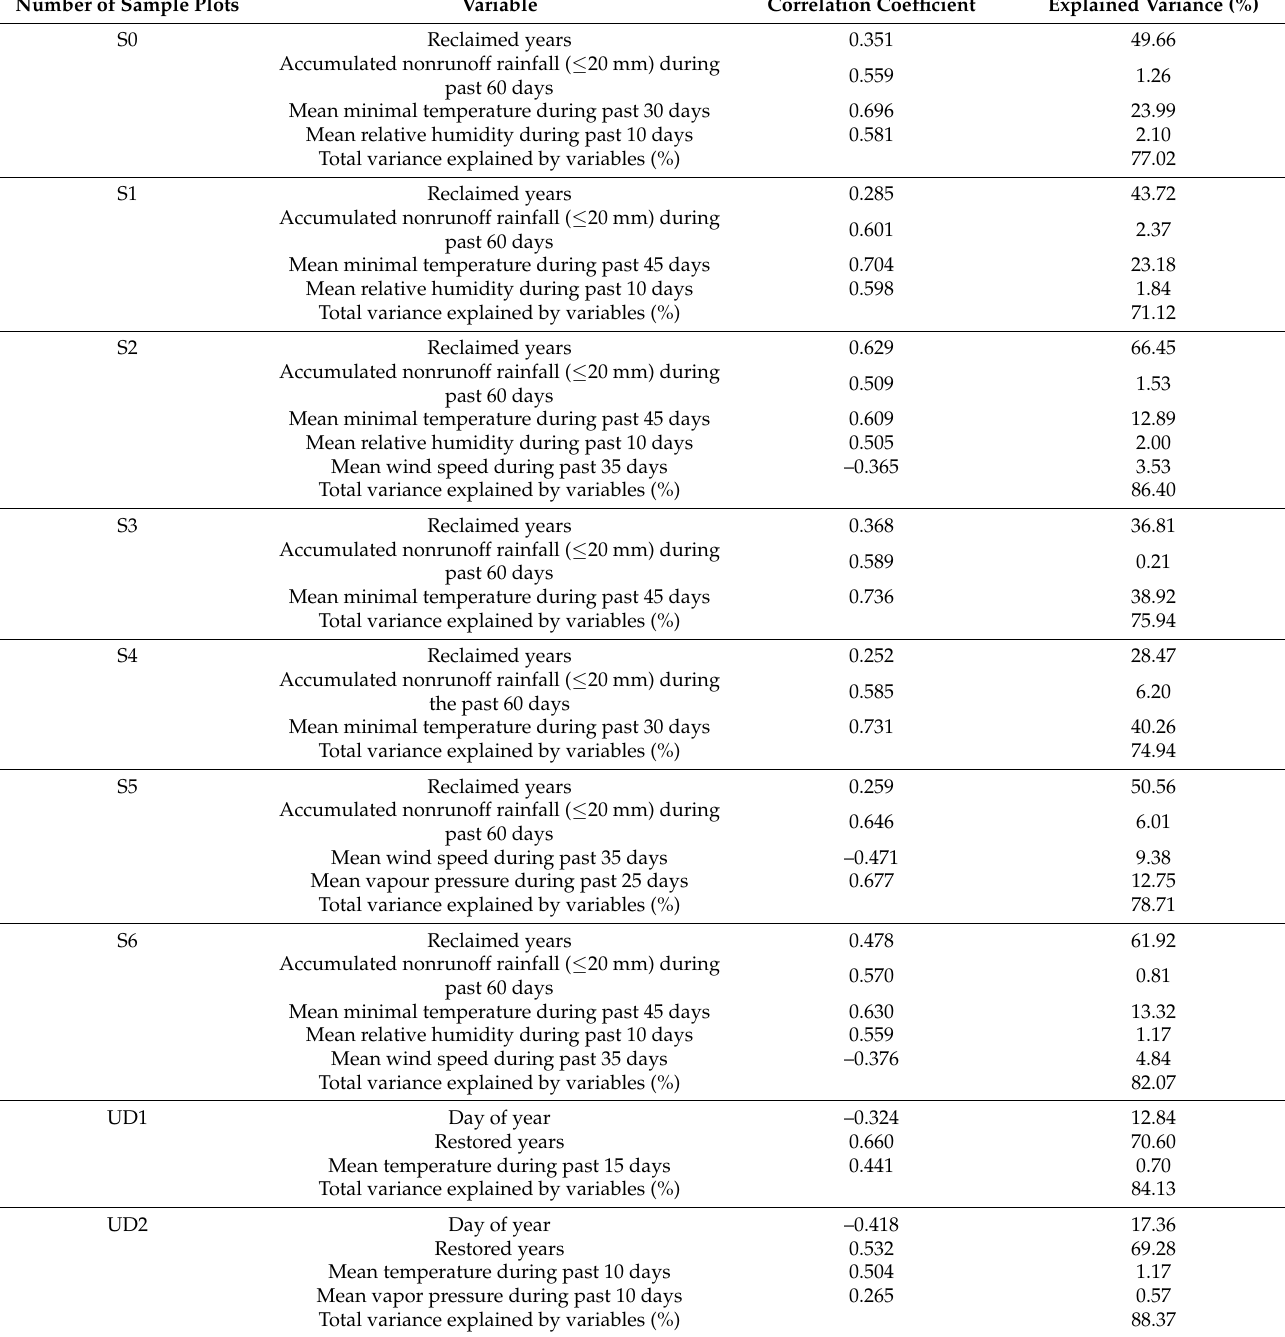
Table 4. Selected explanatory variables for EVI variations in each sample plot, their correlation coefficients with EVI, and contributions quantified by variance explained by